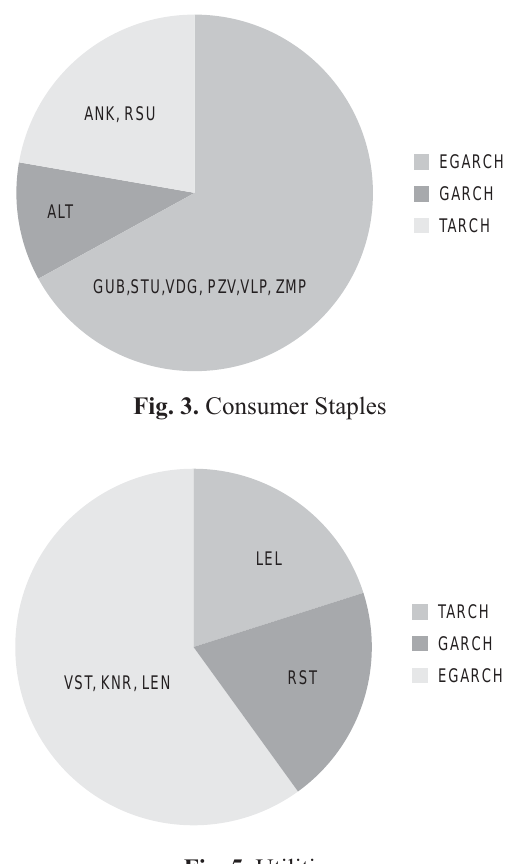
Fig. 4. Consumer Discretionary Fig. 5. Utilities